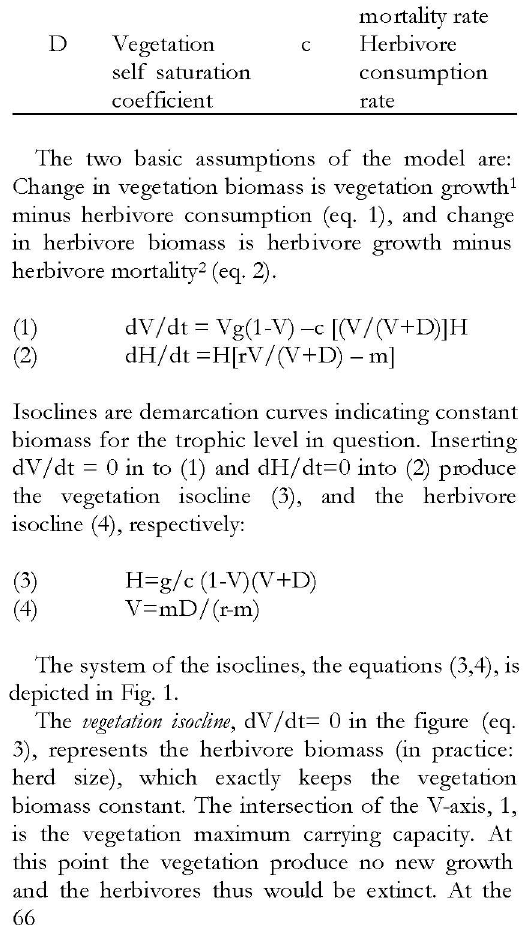
Table 1. Factors and parameter in a one-pasture herbivore model.